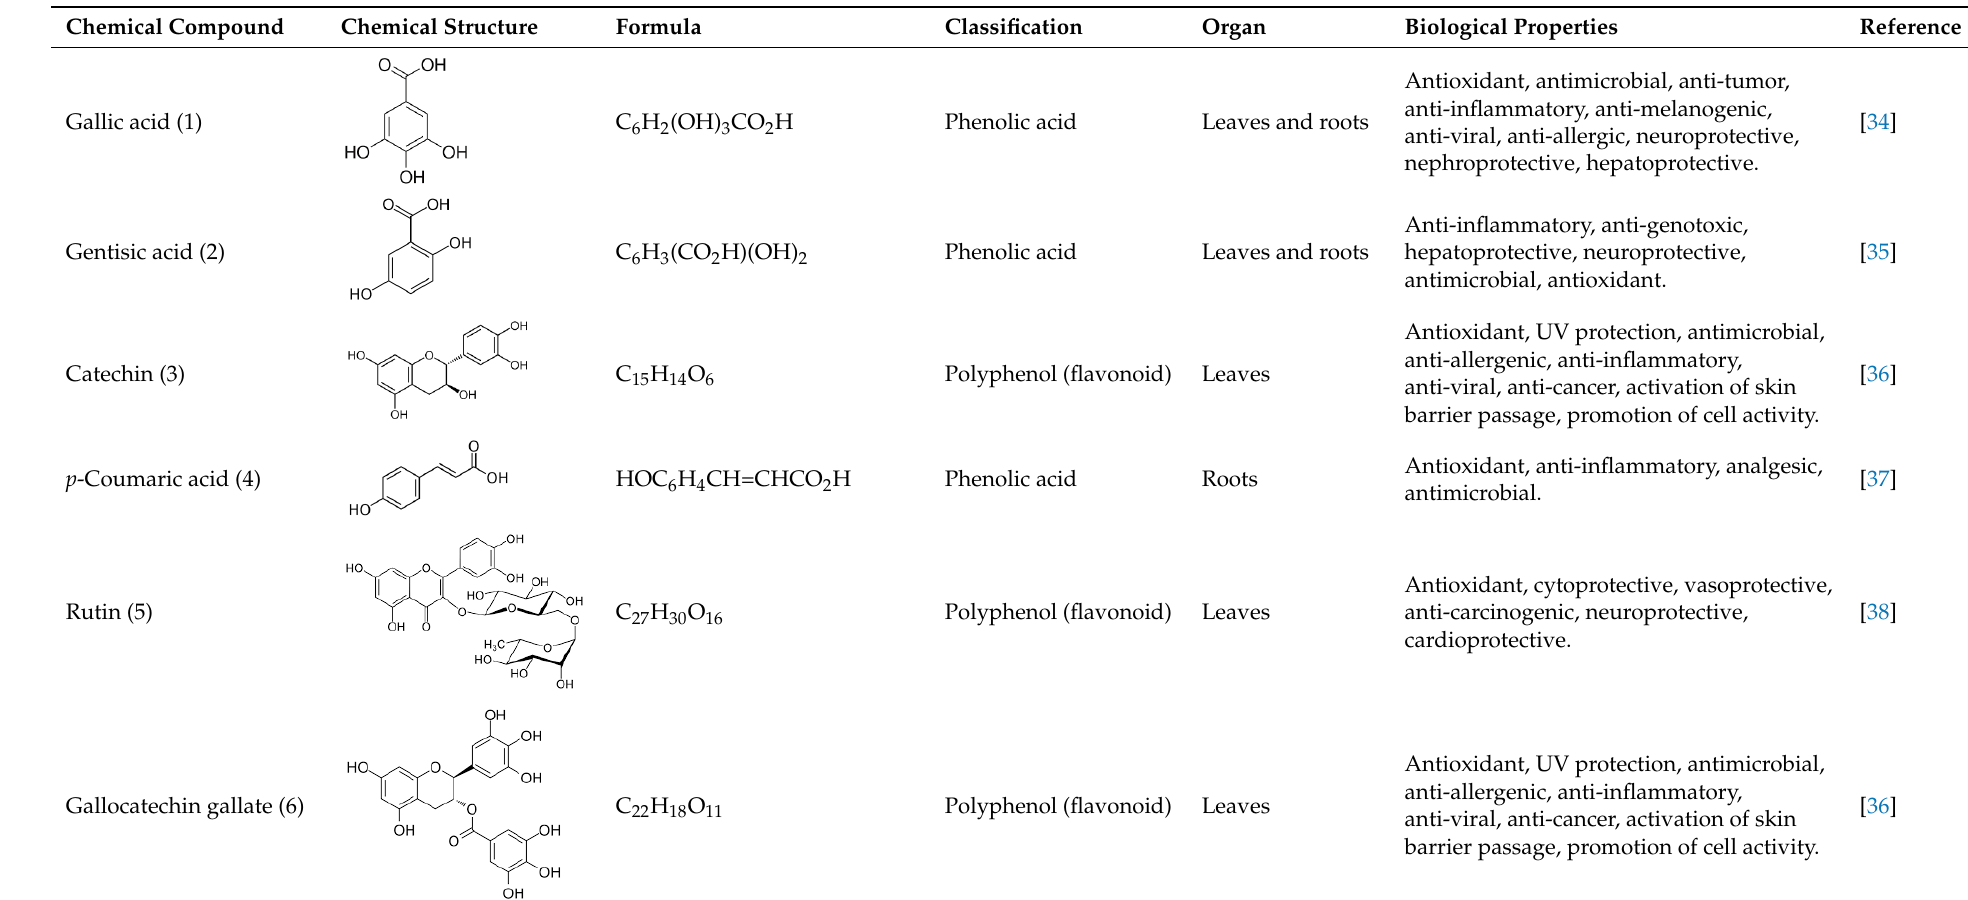
Table 2. Molecules identified in L. intricatum extracts.